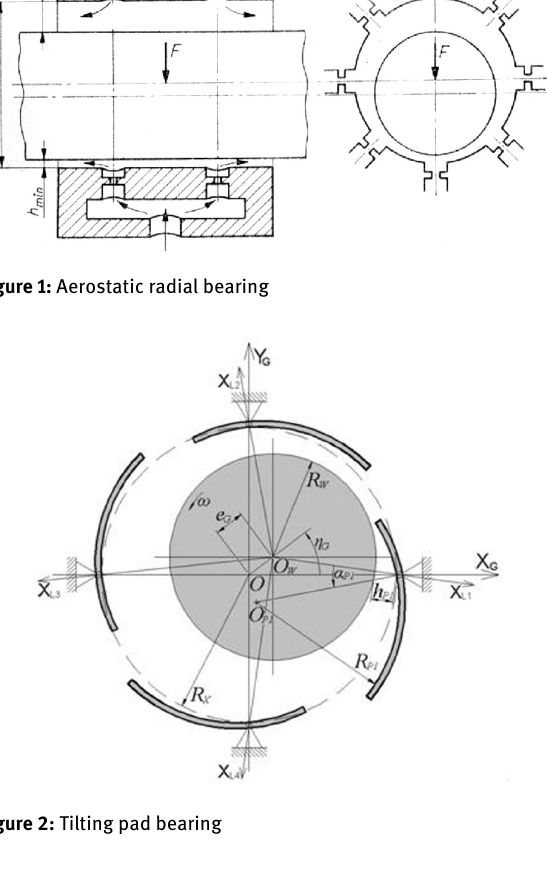
of the rotor-bearing-casing system within the whole range of machine operation should be analyzed